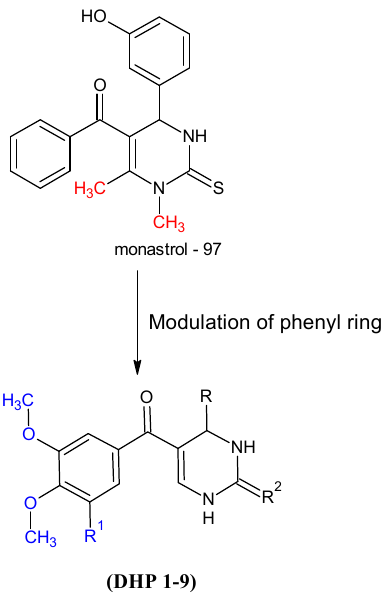
Figure 2. Lead compound Monstrol-97 and newly synthesized compounds ( DHP 1 – 9 ).